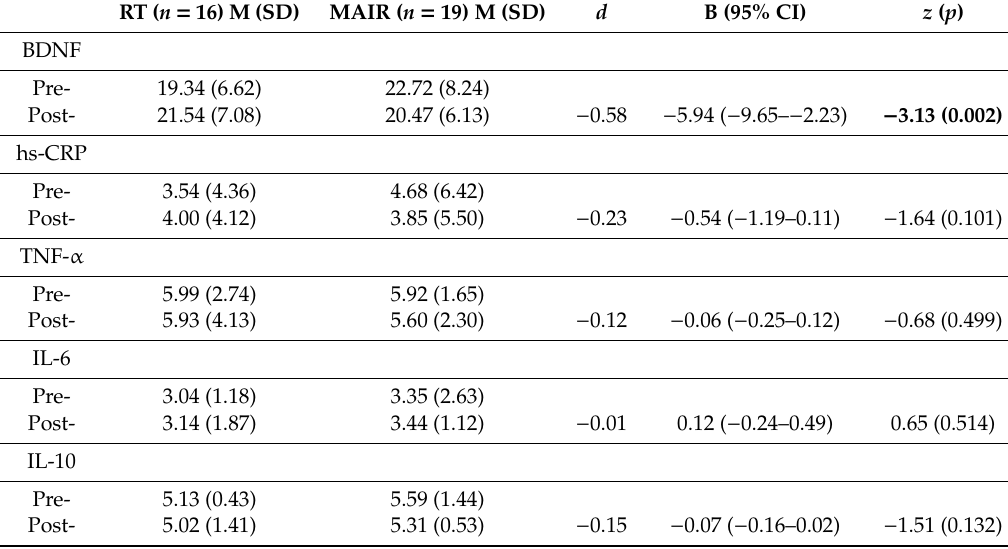
Table 4. Analyses of serum